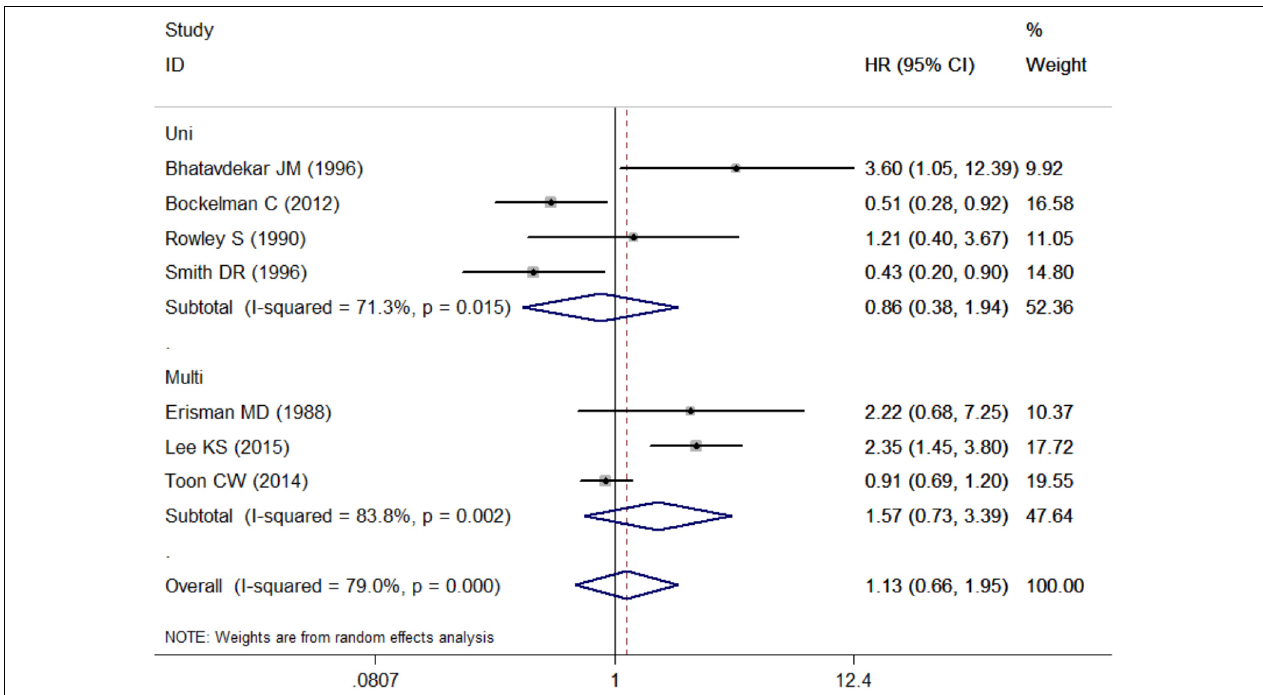
FIGURE 4 | Subgroup analysis for the association between c-Myc and overall survival in the studies using different analytic methods. Uni, univariate analysis; Multi, multivariate analysis.